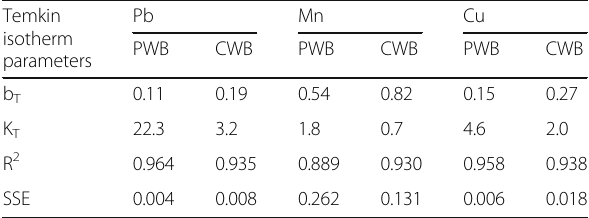
Table 5 Temkin isotherm parameters for adsorption of Pb, Mn and Cu onto BC in the